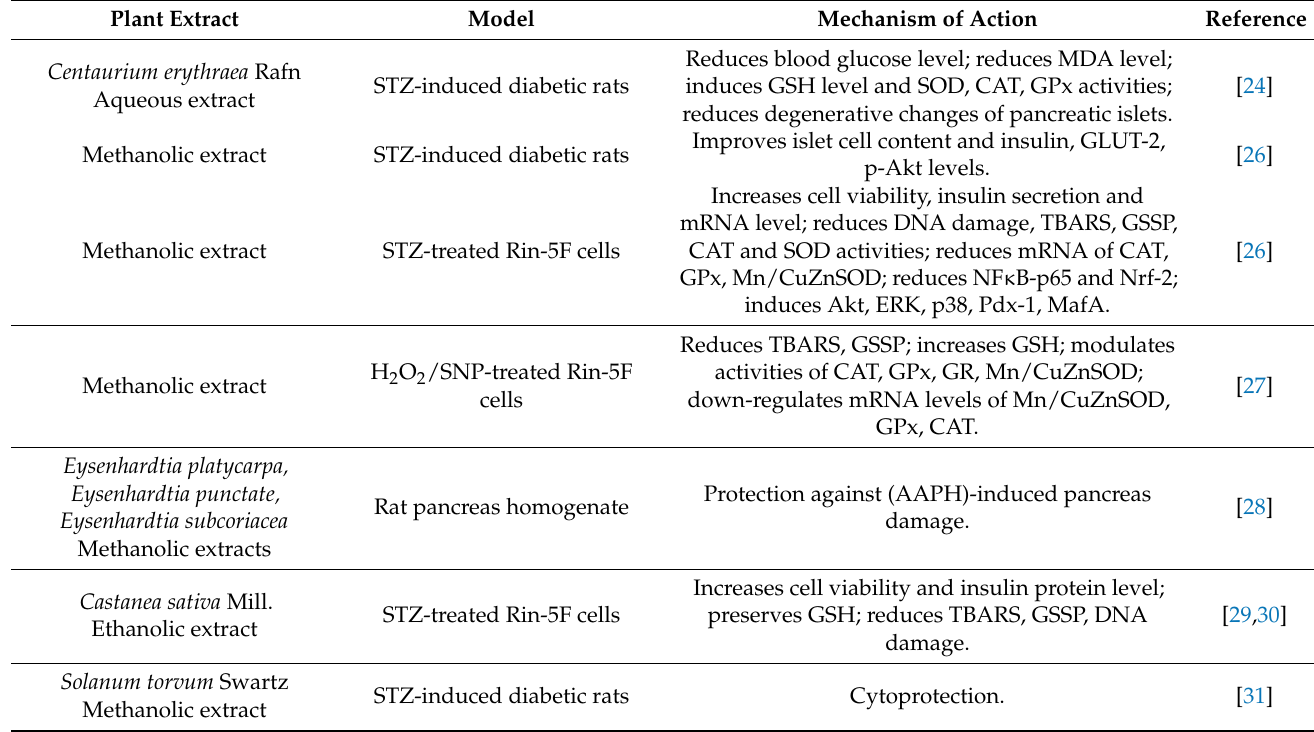
Table 1. Plants with protective effects on pancreas in diabetes